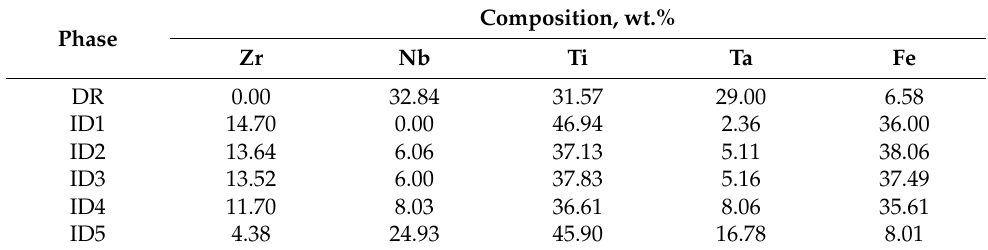
Table 5. EDS compositions for the remelted FeTa 0.5 Nb 0.5 Ti 1.5 Zr 0.5 alloy, in